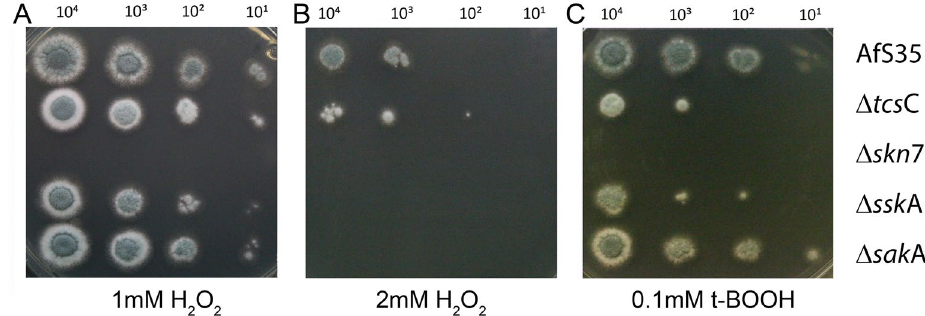
Figure 5. Growth of the HOG pathway mutants under oxidative stress conditions. Drop dilution assays on AMM plates containing 1 mM H 2 O 2 (panel A ), 2 mM H 2 O 2 (panel B ) or 0.1 mM t-BOOH (panel C ) were incubated for 48 h at 37 °C. The strains and the number of conidia that were applied per drop are